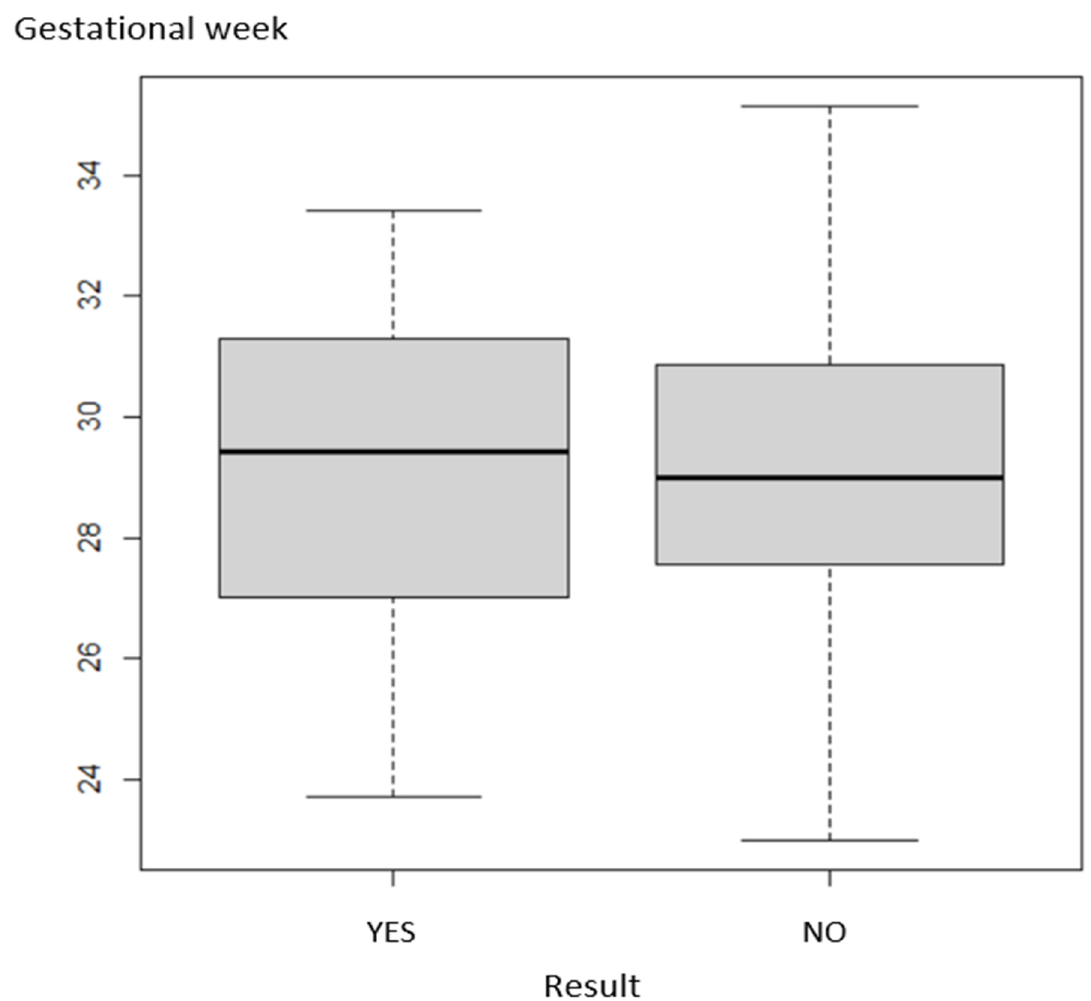
Figure 1. Dependence of positivity on gestational age ( p = 0.983).